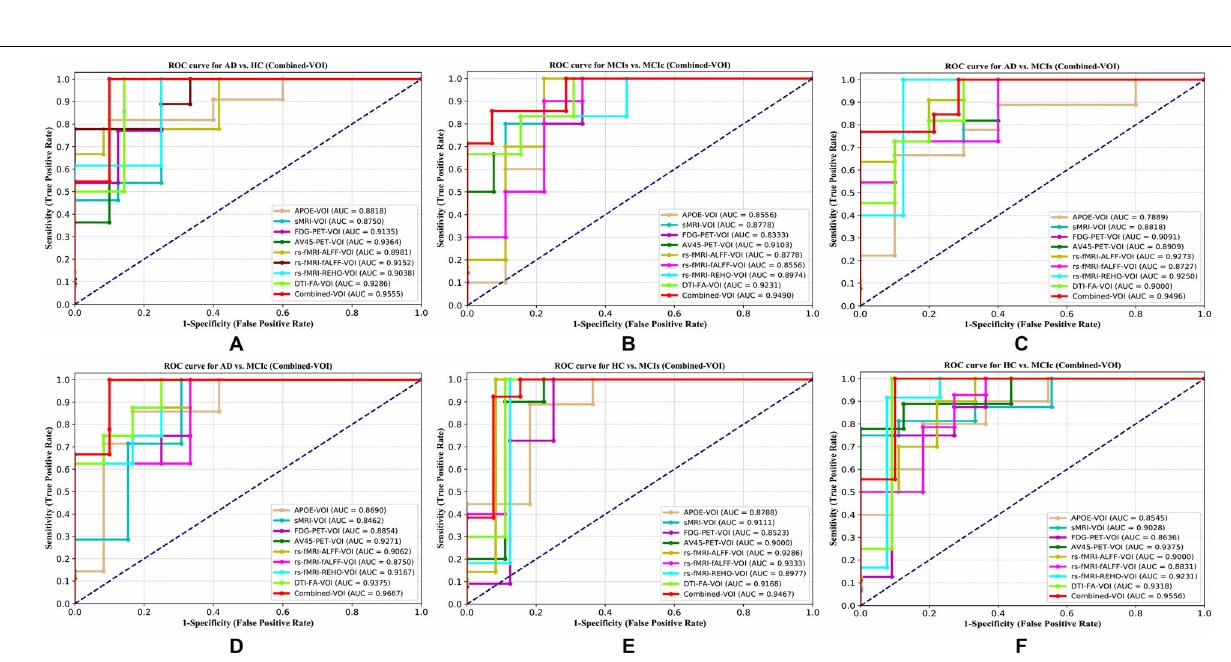
FIGURE 9 | ROC curves for (A) AD vs. HC, (B) MCIs vs. MCIc, (C) AD vs, MCIs, (D) AD vs, MCIc, (E) HC vs. MCIs, and (F) HC vs. MCIc using voxel-wise (VOI) analysis. The red solid line shows the result of the combined-VOI curve, including all single-modality